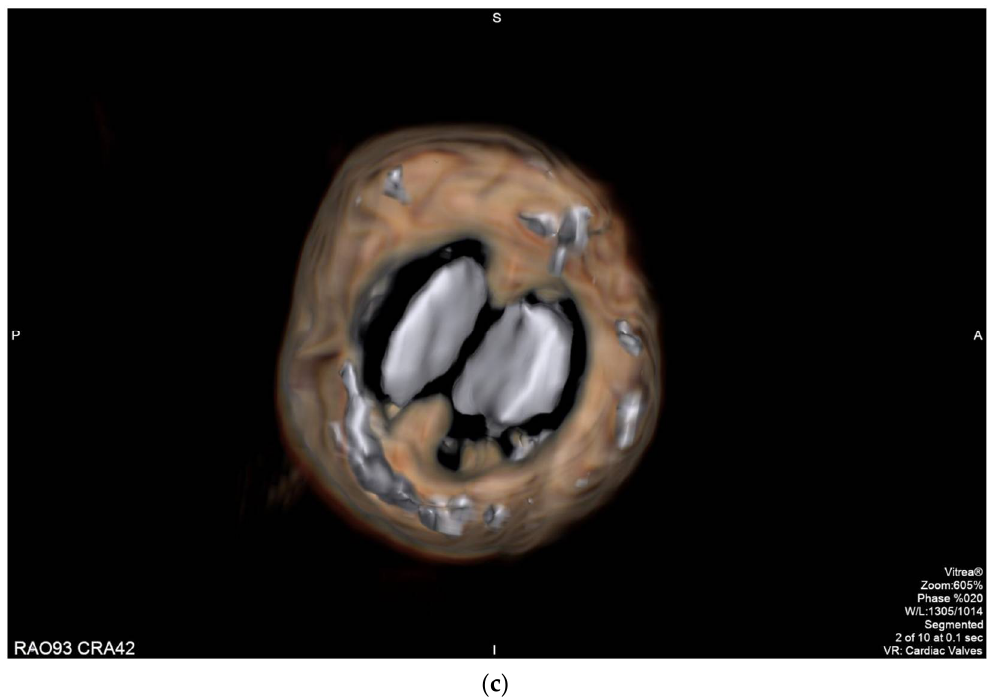
Figure 1. MPR of a St. Jude PHV (10% of the RR interval): long-axis view showing the maximum opening angle of the anterior and posterior leaflets, 55.7° and 63.9° (normal range, 75–90°), respectively ( a ); region of interest (ROI) on the periprosthetic hypodense tissue ( b ); 3D anatomical model of the PHV involved by the pannus ( c ).